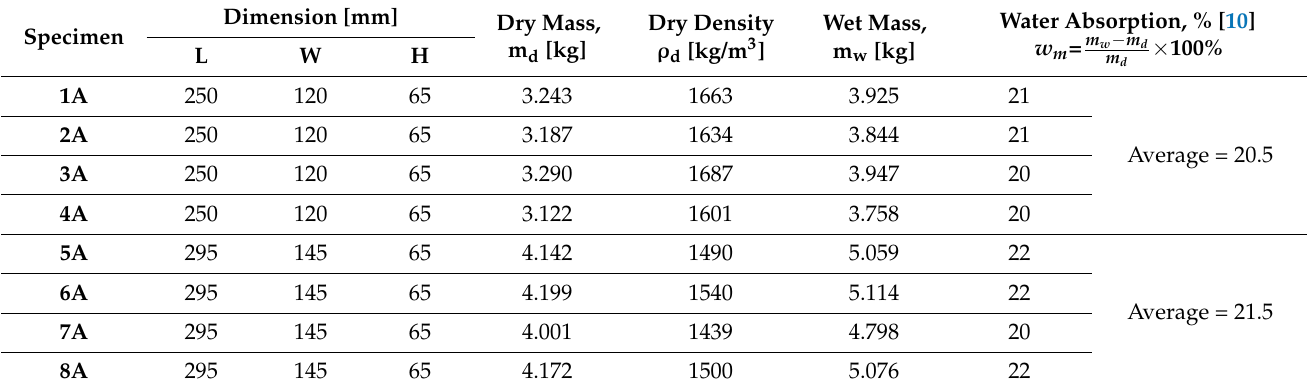
Table 2. The original specimen’s physical properties.